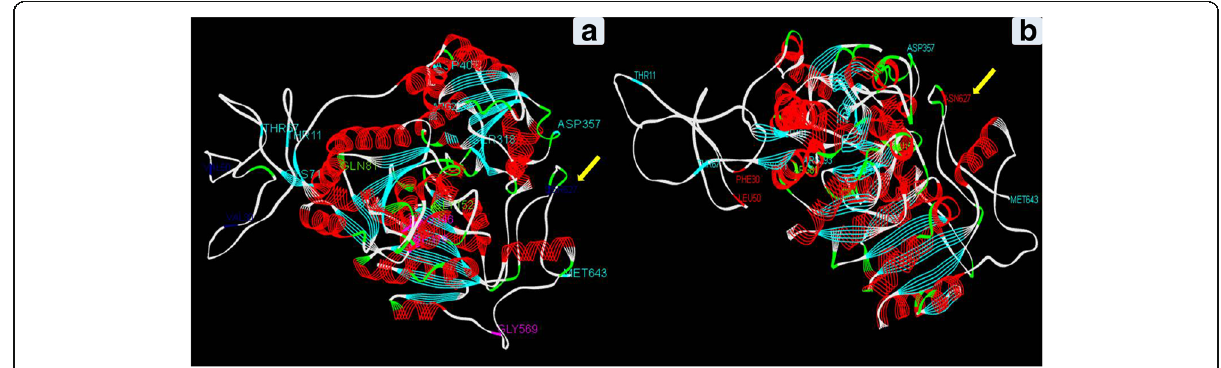
Fig. 6 Line ribbon representation of the homology based protein model of WT ( a ) and HTM-N22 ( b